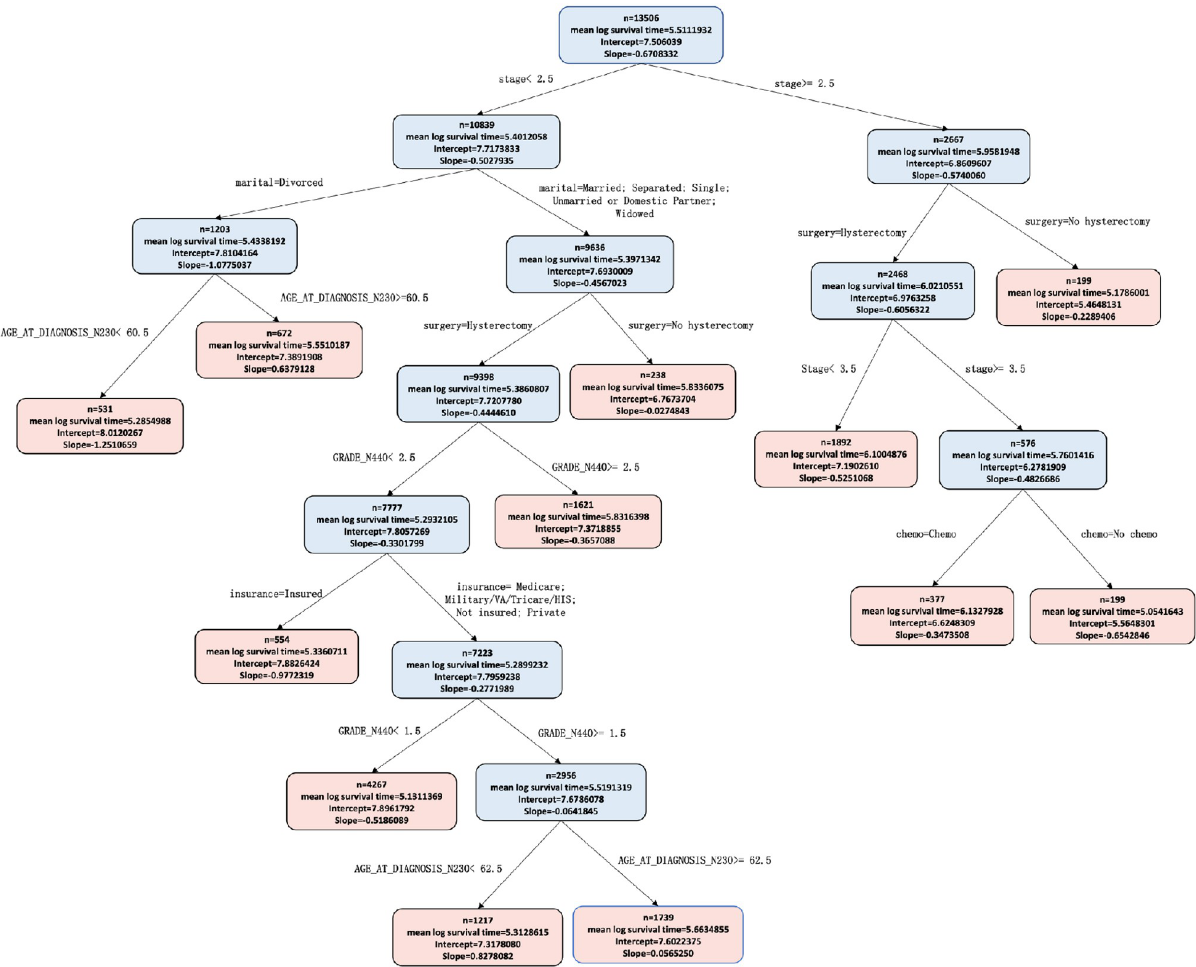
Fig 2. PRISM tree. Inside each terminal node of the PRISM tree is printed sample size, mean log survival time, the intercept and slope effect for race.